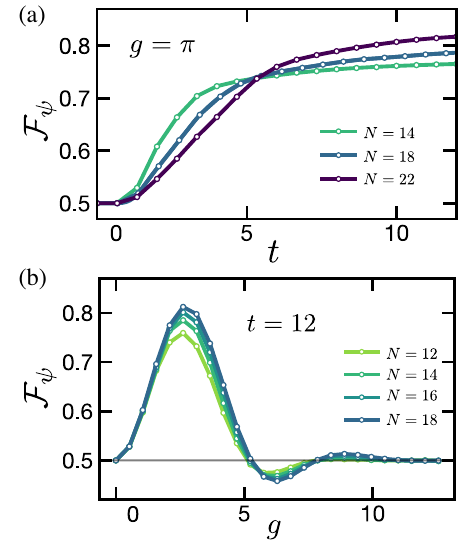
FIG. 8. Finite-size scaling of the Rydberg simulations (a) as a function of time with g ¼ π and (b) as a function of coupling strength g with t ¼ 12 . The system is evolved under the Rydberg Hamiltonian [Eq. (104)] with the same system parameters as in Fig. 7. At late times, the fidelity increases for larger systems but decreases for larger values of g . This is consistent with our error analysis in Sec. VII; in particular, we expect the error to scale as g 2 δ S 2 =N 2 and the size distribution to approach a binomial ffiffiffiffi p N distribution for which δ S ∼ S = . In contrast, at early times, smaller systems exhibit a larger fidelity not because of the size g S ð t Þ =N , where η g is width but because the acquired phase is η d d fixed and S ð t Þ is initially independent of size. The curves in (a) intersect near the scrambling time due to the transition between the early- and late-time